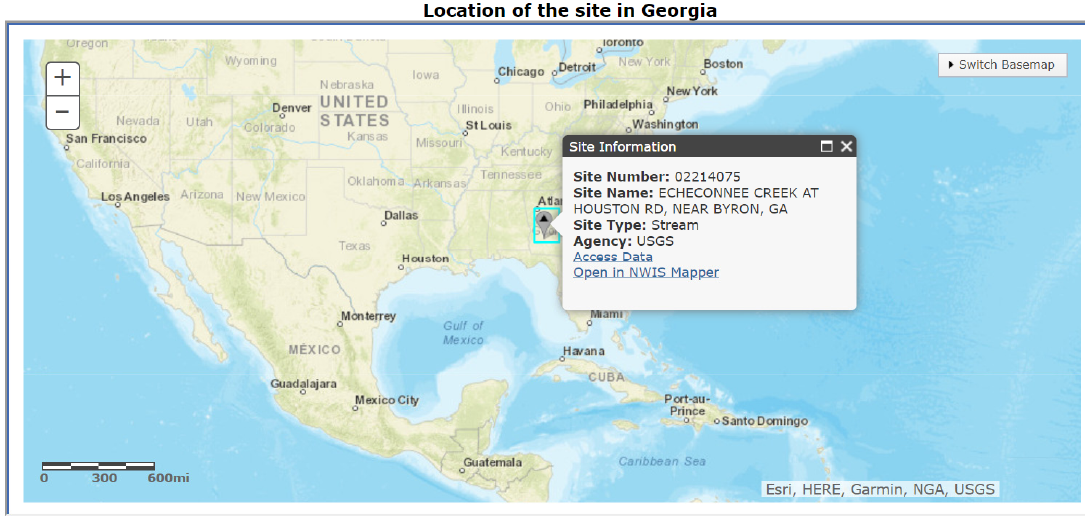
Figure 4. Echeconnee Creek station and its location in Georgia, USA.